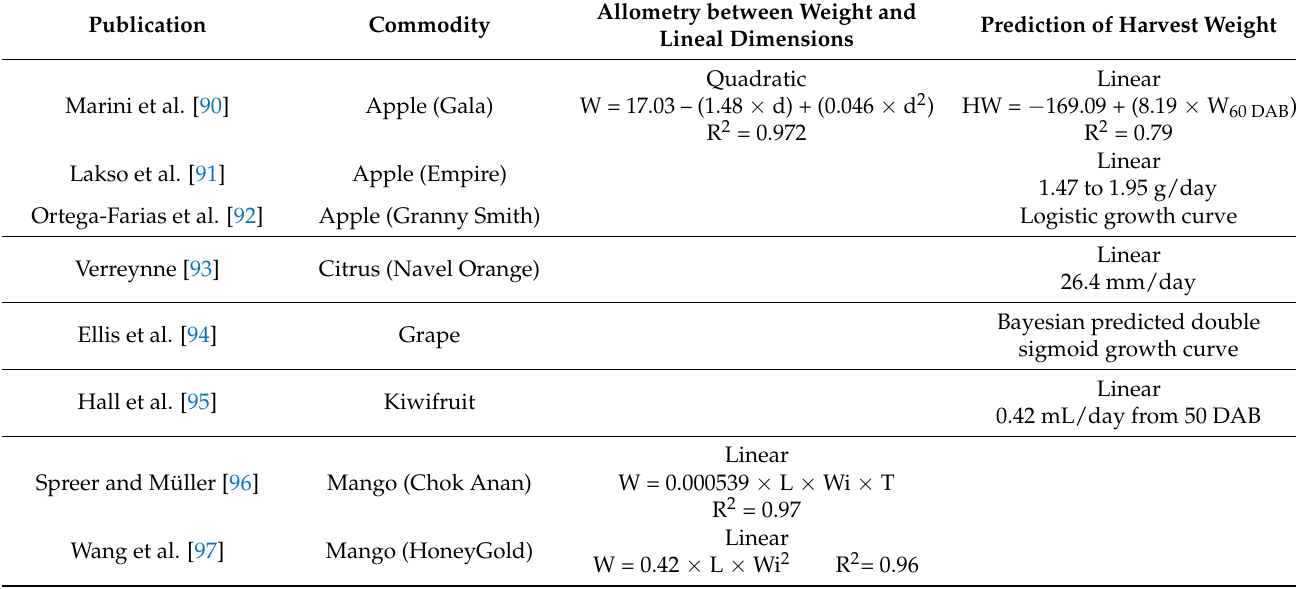
Table 5. Examples of allometric relations between fruit lineal dimensions and weight, and growth models for prediction of size at harvest, for several commodities. Abbreviations are: W, fruit weight (g) at a given time, e.g., W 60 DAB ; where DAB is days after full bloom; HW, weight of fruit at harvest (g), L, fruit length (mm), Wi, fruit width (mm), T, fruit thickness